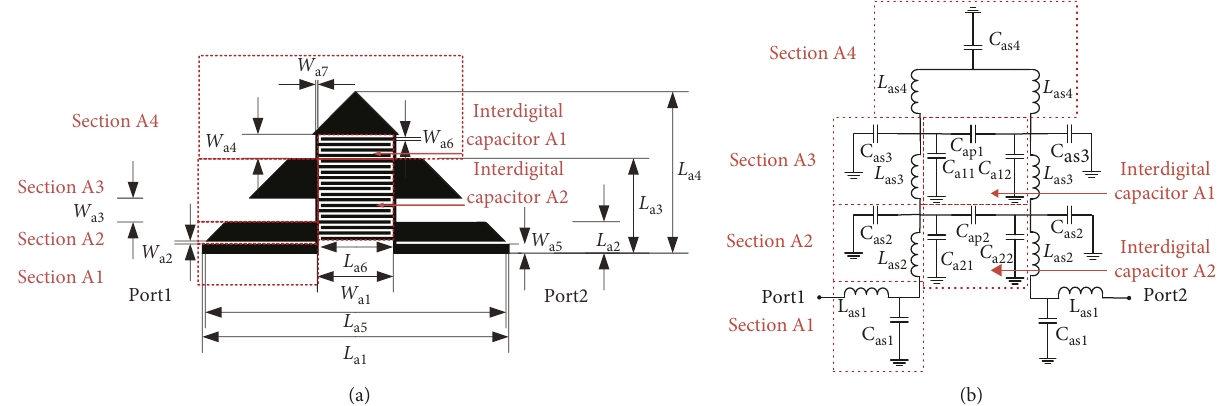
Figure 1: A section of 70.7 Ω ATL with a right-angled triangle shape: (a) layout and (b) equivalent circuit.